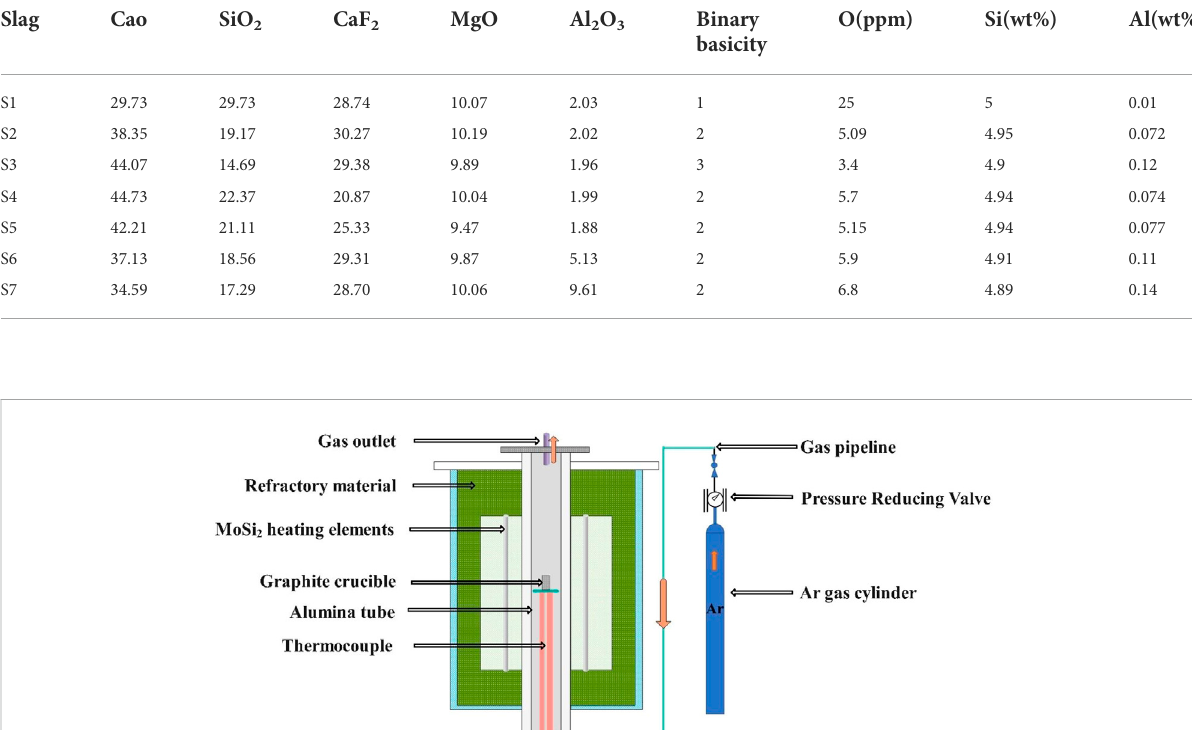
TABLE 4 Chemical composition of slags used in the study (wt%) and chemical composition of steel in the experimental ingots.